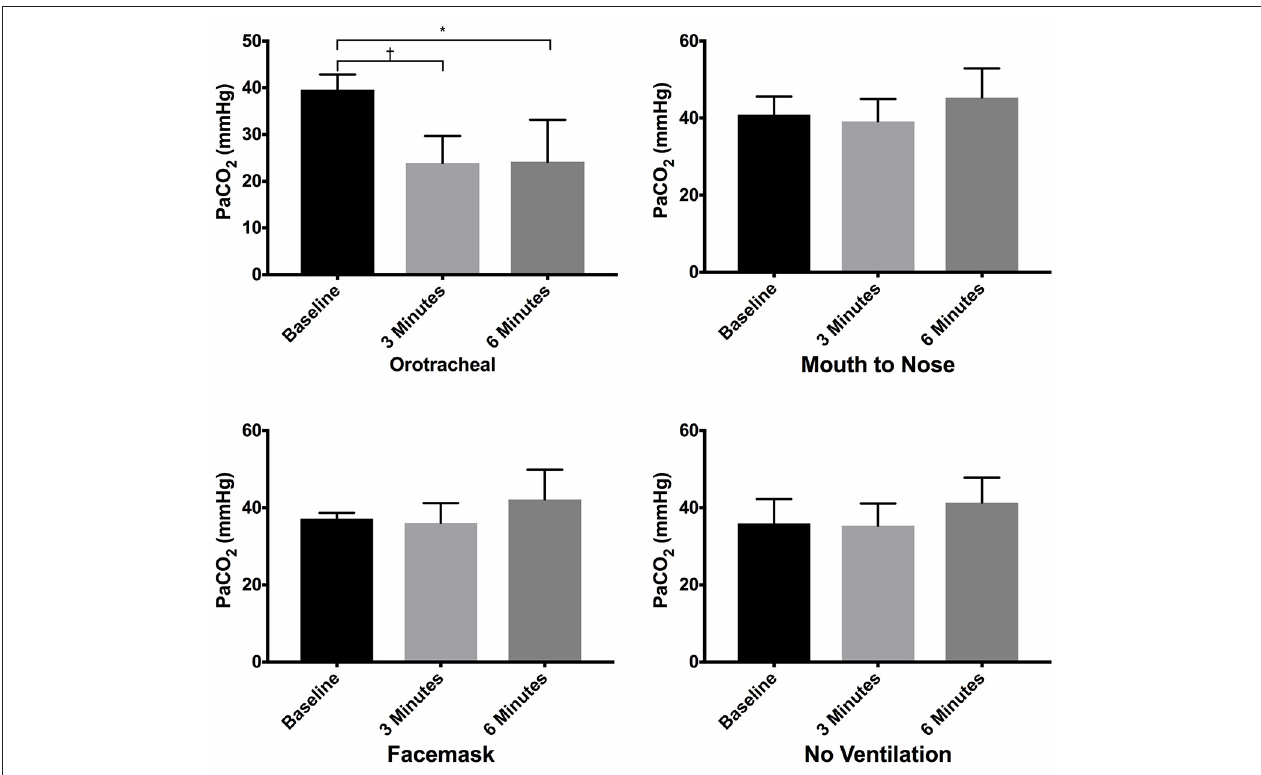
FIGURE 4 | Mean PaCO 2 of dogs at baseline and at 3 and 6min of cardiopulmonary resuscitation for each ventilation technique. Bars represent standard deviation. * P < 0.05, † P < 0.005. Orotracheal, ventilation with bag resuscitator and cuffed orotracheal tube; Mouth-to-nose, rescue breaths with mouth over the nose; face mask, ventilation with bag resuscitator and a tight fitting face mask; No ventilation, compression only